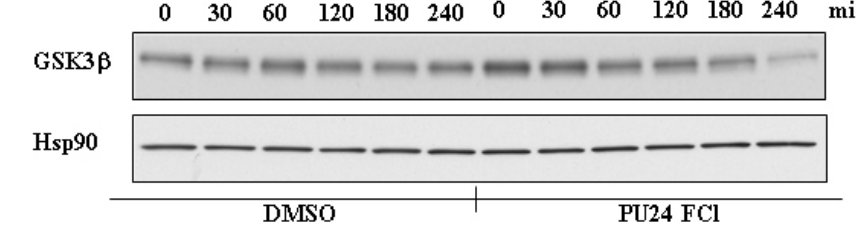
Figure 4. Hsp90 inhibition affects the protein’s half-life. COS-7 cells were treated with DMSO or 10 µ M PU24FCl in the presence of 30 µ M cyclohexamide to halt translation. At the times indicated, cells were lysed and whole-cell lysates immunobloted with anti-GSK3 b antibody.